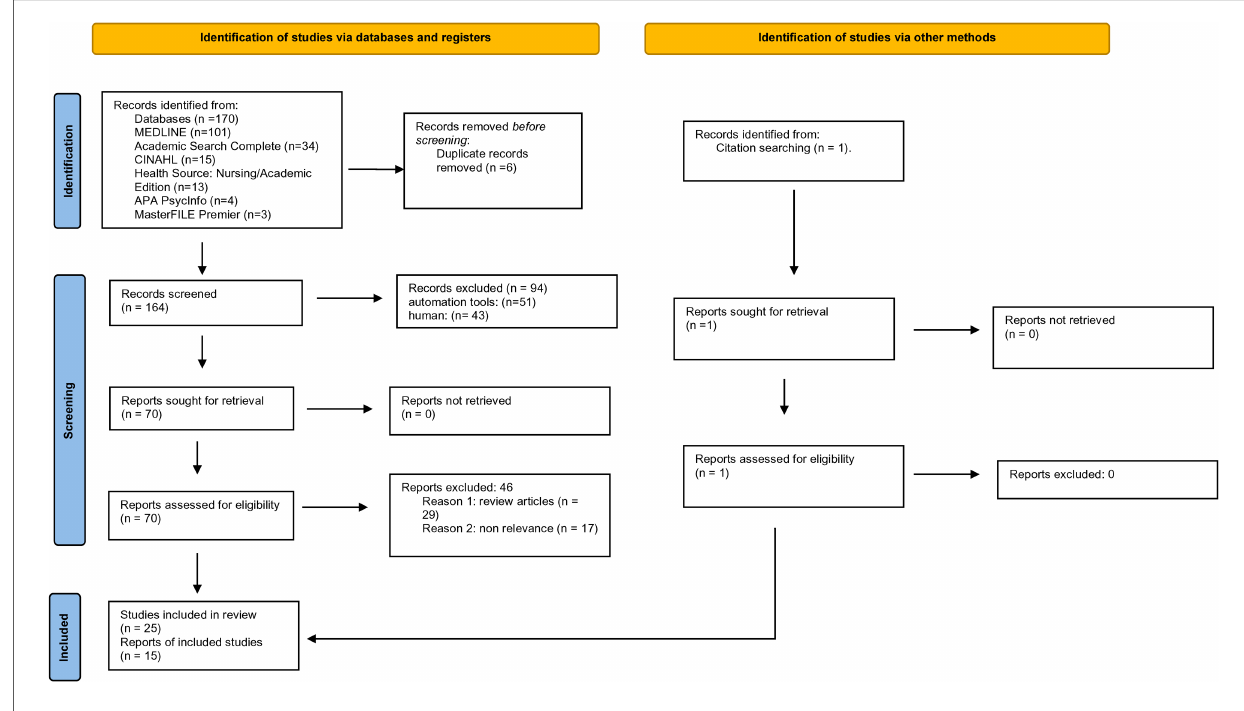
FIGURE 1 PRISMA fl ow diagram illustrating the study selection